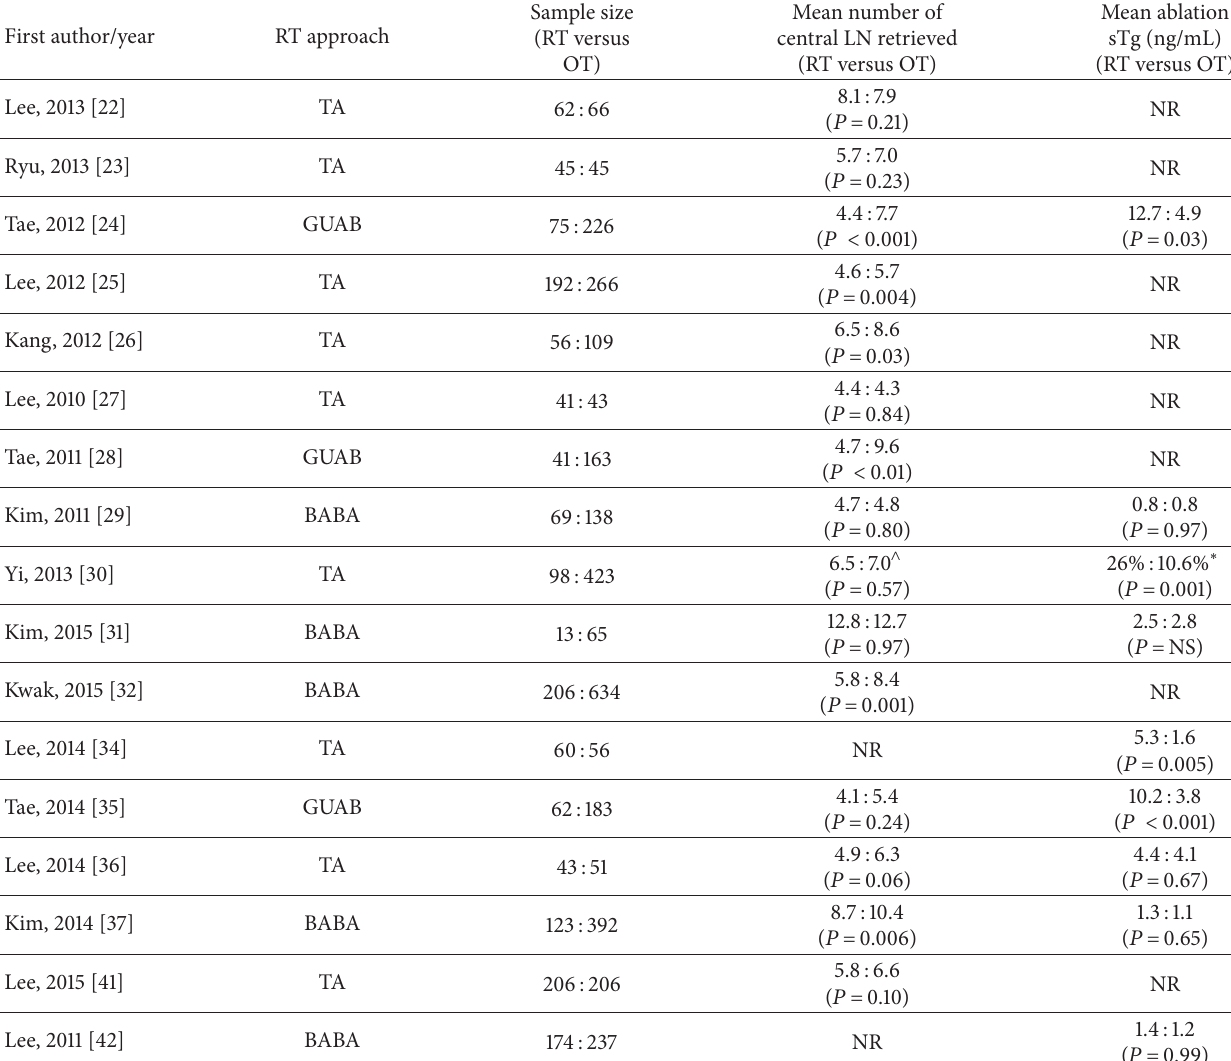
Table 3: Summary of oncological outcomes in published